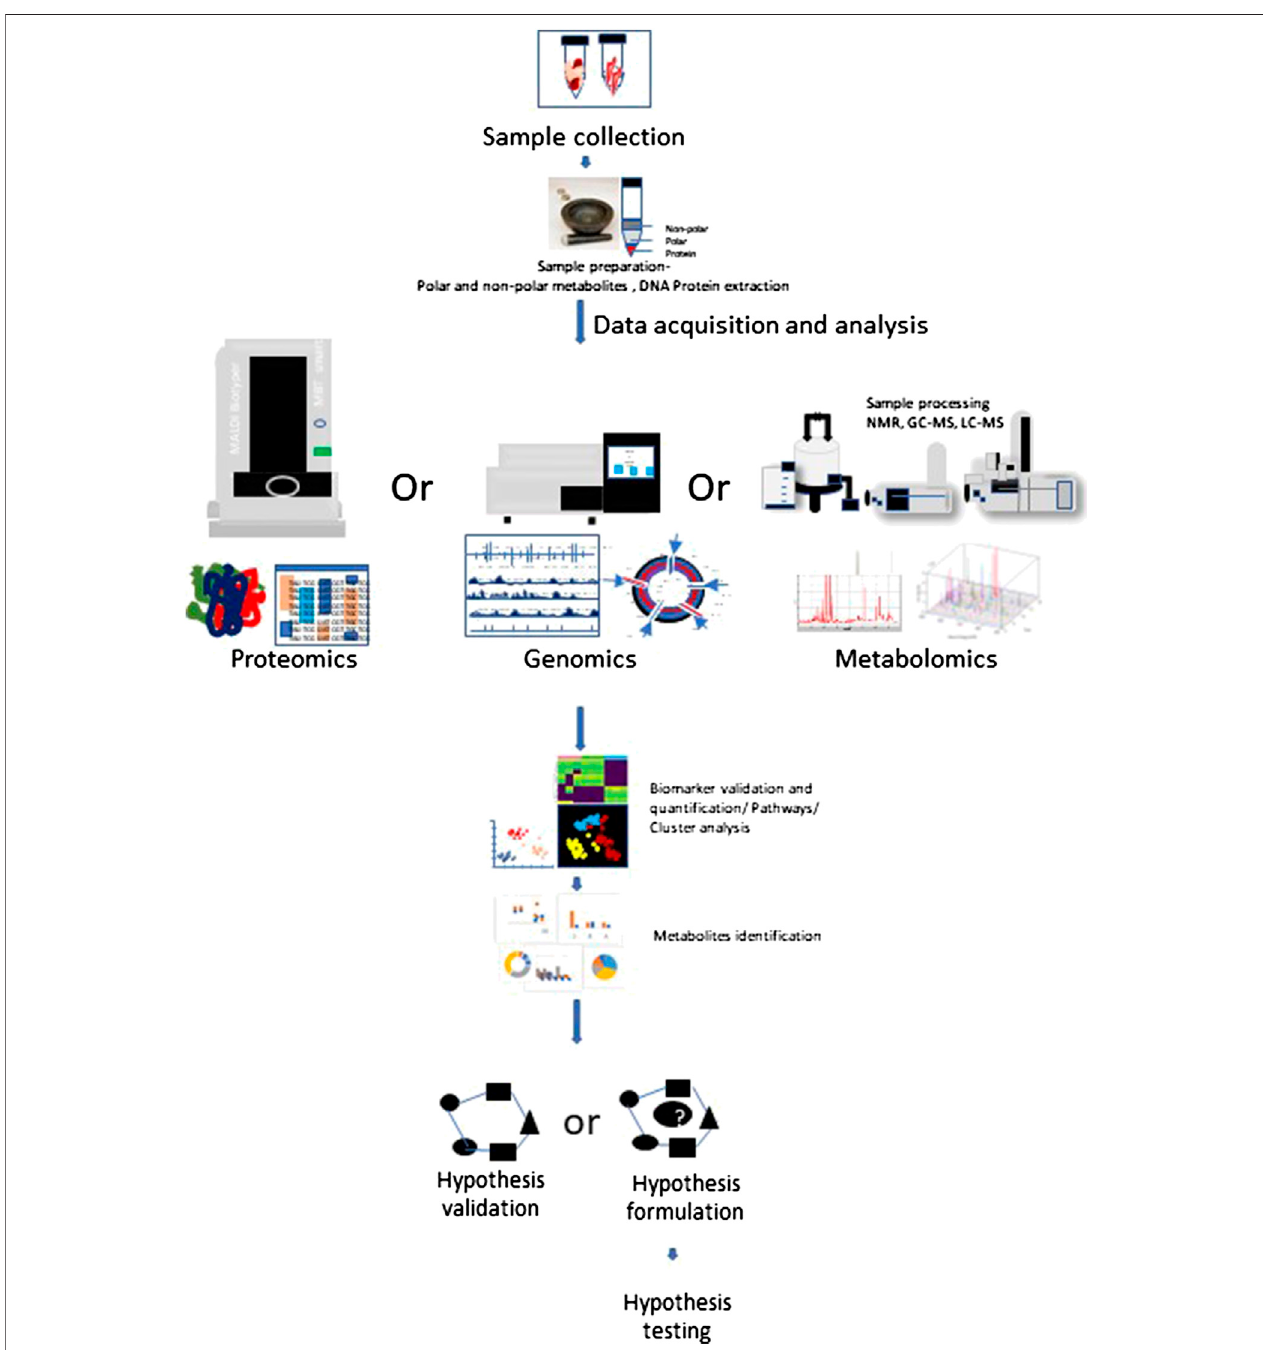
FIGURE1| Multi-omicswork fl ow.MetabolomicsanalysisinvolvestissuecollectionwhichneedstobesnapfrozeninliquidNitrogen.Frozentissuesaremincedand subjected topolar and non-polar metabolites, DNA, Protein extraction accordingto the requirement for target and processed further forrespectiveapproach. Collected data is subjected to metabolites detection, data reduction and analysis, which may help to generate or prove a hypothesis.